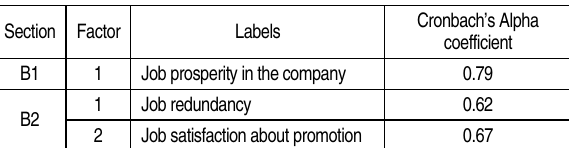
Table 2. Reliability of factors